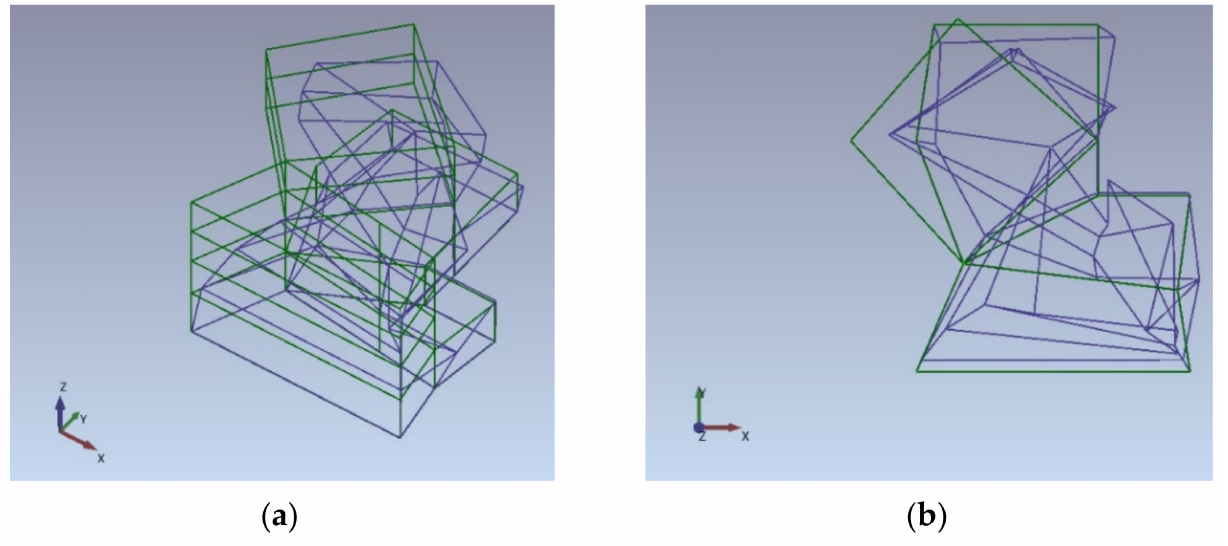
Figure 11. First experimental mode is a torsional-bending mode along x (in green the un-deformed configuration and in blue the mode shape): ( a ) 3D view; ( b ) plan view.